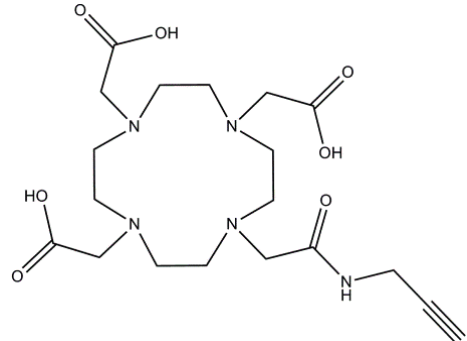
Figure 10. Chemical structure of Product 6